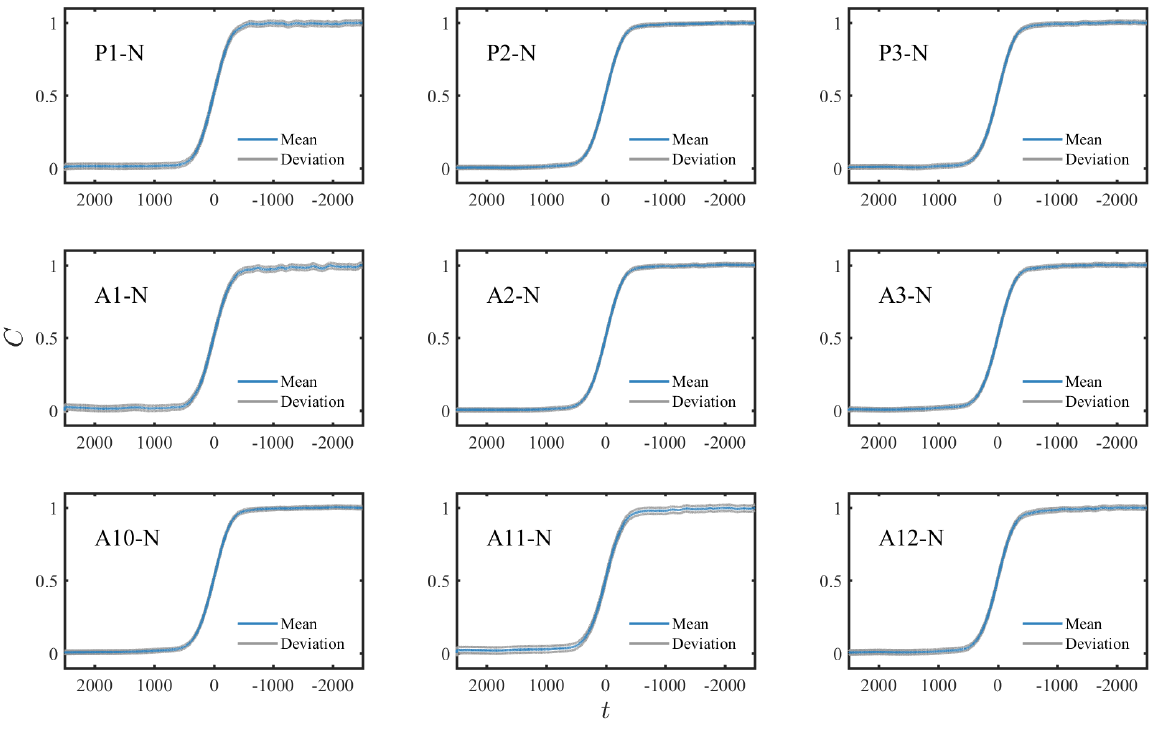
Figure A3. Experimental error estimate for five repeated runs. The blue curve is the mean of the experiments that measured at the north (N) branch at each location and the gray curve is the average